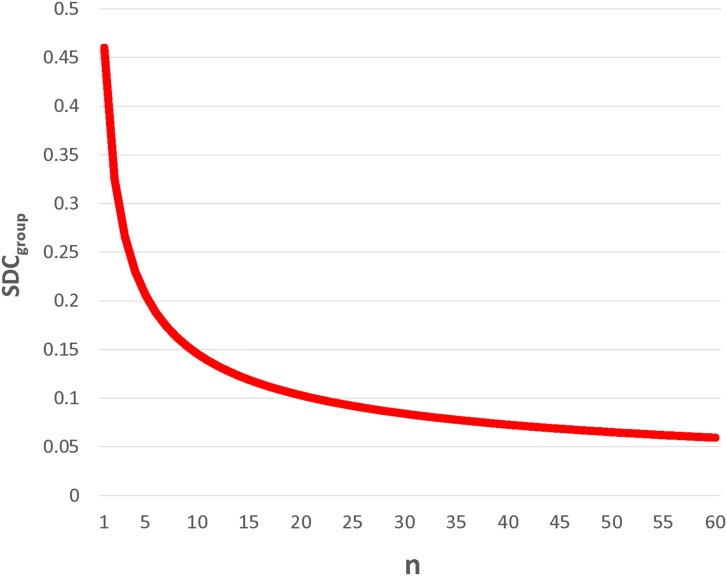
SDCgroup
decreases dramatically with increasing n. This example, using SICI80 in lesioned hemisphere of subacute stroke, demonstrates for that for an individual, the SDC is quite large, requiring a change greater than 0.45 in SICI80 in the lesioned hemisphere to be deemed real. By calculating SDCgroup (= SDCindiv/n), it is apparent that even with modest sample sizes of 10–20, changes exceeding measurement error could be conceivably detected, and the measure would be considered reliable.